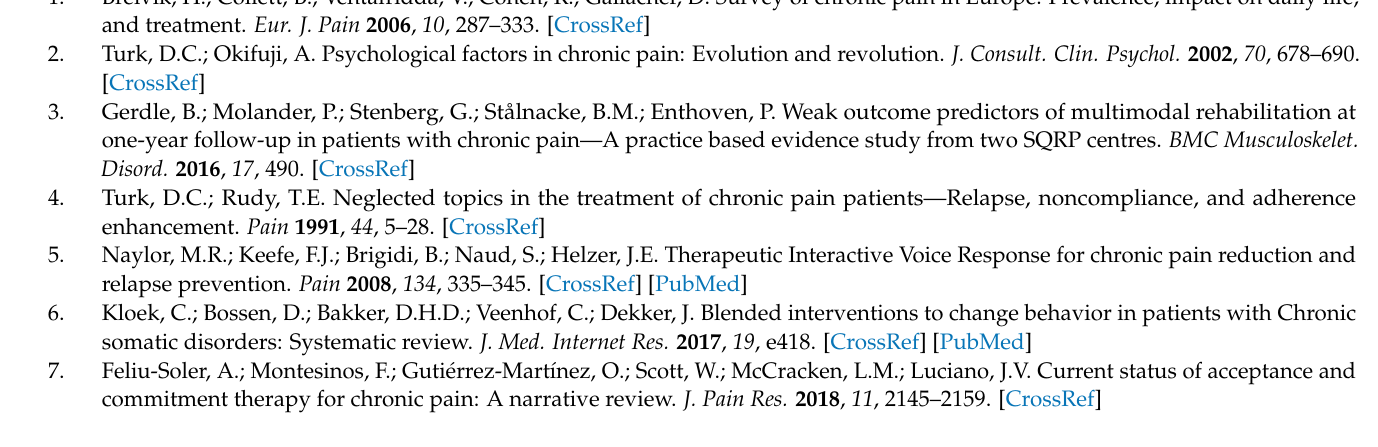
Table S3: Outline IACT added after